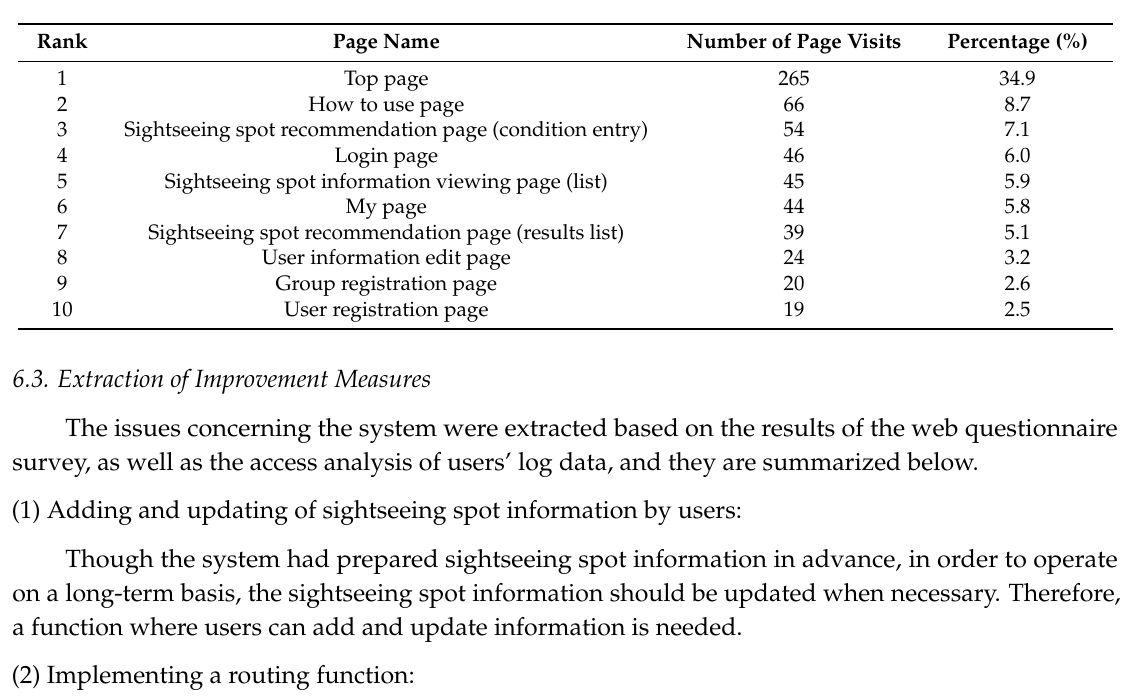
Table 3. Number of visits according to page (top